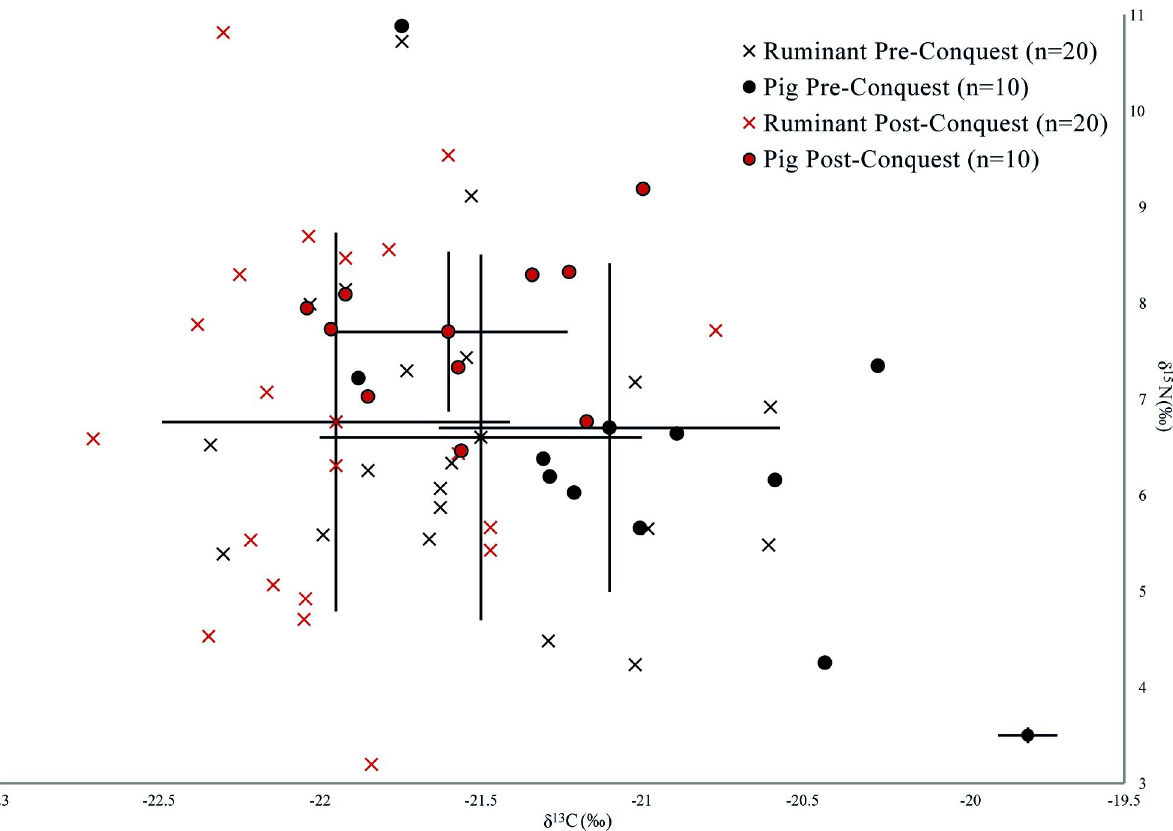
Fig 4. δ 13 C and δ 15 N isotope data from animal bone collagen organised by phase. Error bars represent one standard deviation and analytical error is displayed at the bottom right of the graph.